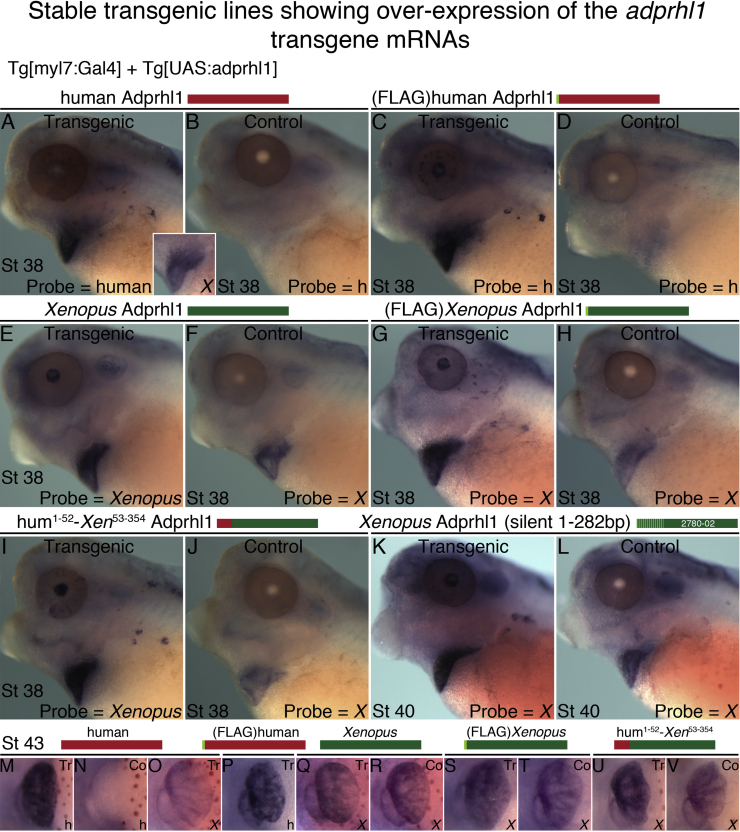
Stable transgenic lines showing over-expression of the adprhl1 transgene mRNAs. A–L: Cardiac adprhl1 mRNA expression in embryos representing six stable Tg[UAS:adprhl1] transgenic lines. A, B: Stage 38 tadpole containing Tg[myl7:Gal4] driver and Tg[UAS:human ADPRHL1] responder transgenes (A), plus a sibling control (B), after in situ hybridization for the human ADPRHL1 RNA. The transgenic tadpole produces ADPRHL1 mRNA in the heart whereas the control does not. The transgenic heart in the inset shows a weaker signal for the endogenous adprhl1 mRNA using a Xenopus probe of equivalent size (Materials and Methods). C, D: Comparable human mRNA synthesis from the Tg[UAS:(FLAG)human ADPRHL1] transgene. E, F: Xenopus adprhl1 mRNA over-expression from the Tg[UAS:Xenopus adprhl1] transgene. G, H: The Tg[UAS:(FLAG)Xenopus adprhl1] transgene, which yields stronger expression than the untagged construct. I, J: Expression driven by the hybrid Tg[UAS:hum1-52-Xen53-354adprhl1] transgene. K, L: Expression from the Tg[Xenopus adprhl1(silent1-282bp)] transgene that contains silent nucleotide changes, shown in a stage 40 tadpole. M–V: By stage 43, the signal for endogenous adprhl1 mRNAs appears stronger and only transgenes with human ADPRHL1 nucleotide sequence sustain elevated mRNA levels. Five of the stable lines are represented, with ventral views of heart ventricles shown. A–L: All transgenic embryos additionally express transient adprhl1 mRNA within the eye lens, because the Tg[myl7:Gal4] driver line has no insulating sequences to separate the γ−crystallin promoter (S. Fig. 12). Eye in situ hybridization signals for the responder mRNA can therefore be used to identify transgenic embryos. The lower-right of each panel lists the species of hybridization probe used. Tr, binary transgenic; Co, control.